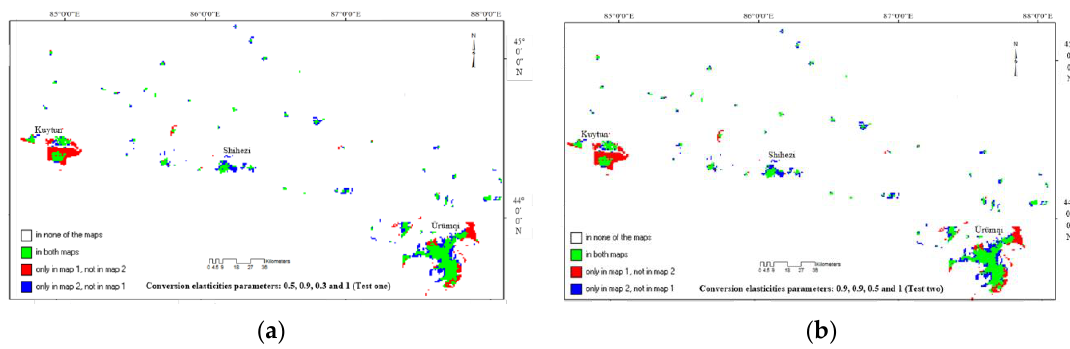
Figure 5. Model simulation results and comparison of two periods: ( a ) Spatial distributions of the forward simulation result in 1989–2007; ( b ) spatial distributions of the backward simulation result in 2007–2013, where in Figure 5a, map1 is the forward simulation results from the CLUE-S model (1989–2007) and map2 is the remote sensing image interpretation (2007, Beijing-1), and in Figure 5b map1 is the backward simulation results from the CLUE-S model (2007–2013) and map2 is the remote sensing image interpretation (2007, Beijing-1).